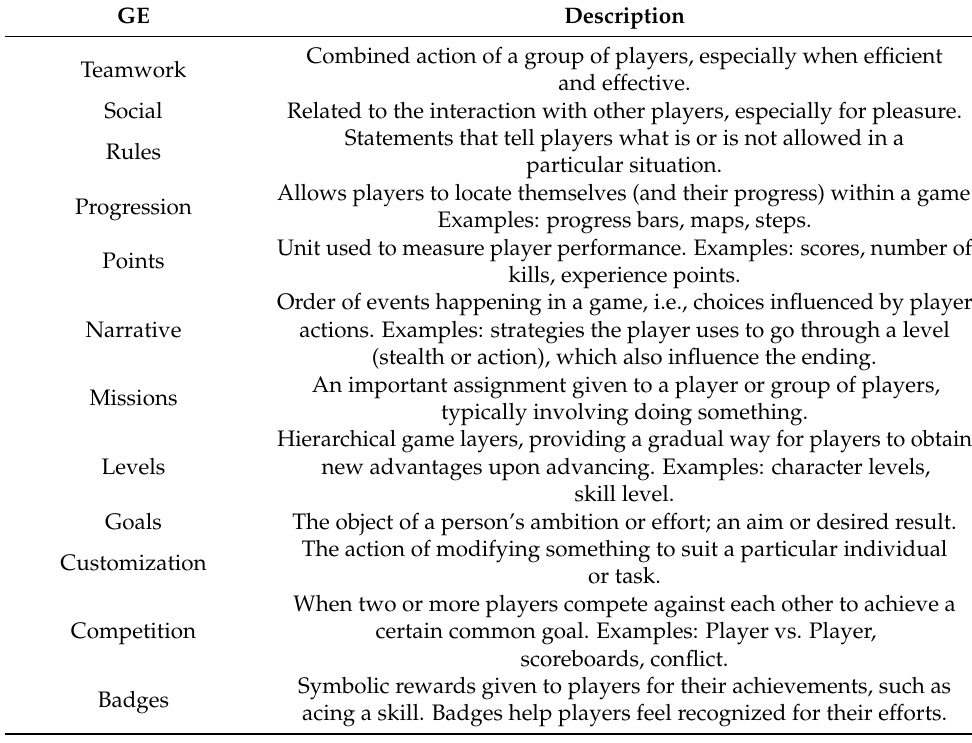
Table 1. Relation of gamification elements